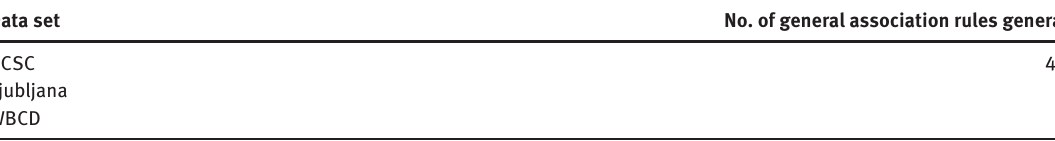
Table 3: Number of Rules Generated for All Three Breast Cancer Data